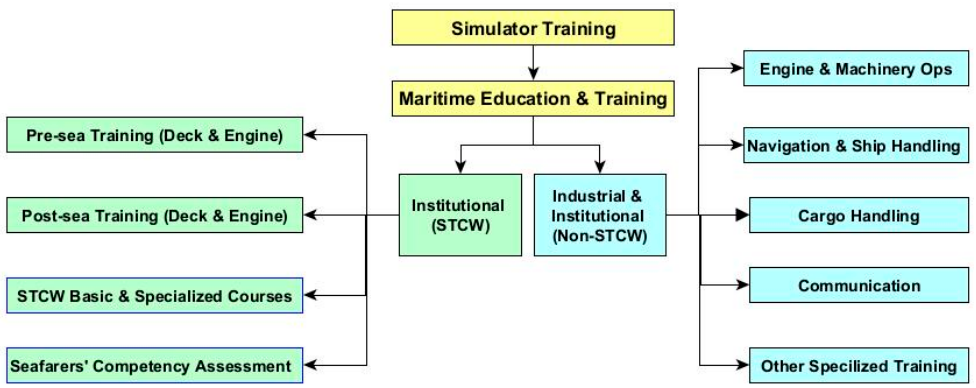
Figure 4. Simulator training in various sectors of MET for institutional and industrial training of STCW and Non-STCW courses for seafarers.